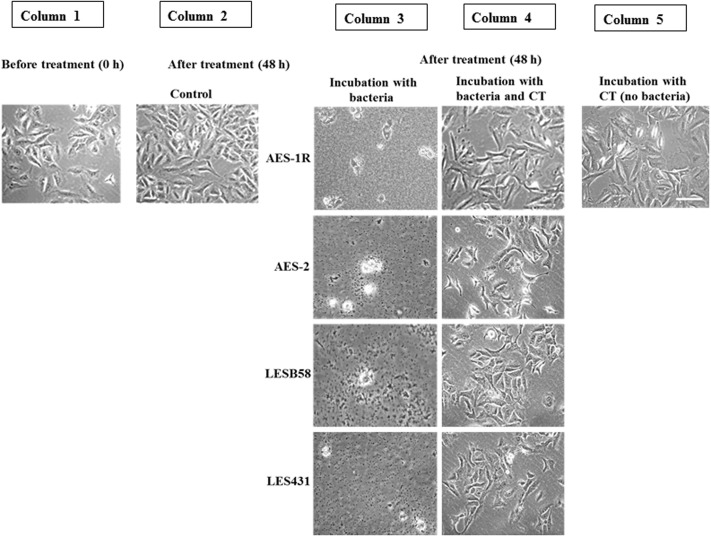
Effect of CT on A549 lung epithelial cells infected with P. aeruginosa CF strains. Uninfected confluent 24 h-old A549 cells (Column 1) were infected with the above P. aeruginosa strains for 48 h. This resulted in the destruction of the A549 cell architecture and colonization of the remains by the bacteria (Column 3). When, A549 cells were incubated with bacteria and CT together, A549 cells were still adherent and maintained their confluence on well plates, with no evidence of bacterial colonization (Column 4), 48 h incubation with CT alone showed maintenance of almost full A549 confluence, (Column 5) similar to the untreated control (Column 2). Scale bar = 50 μm. Image shown is representative of all results, n = 3 experiments performed in biological replicate.